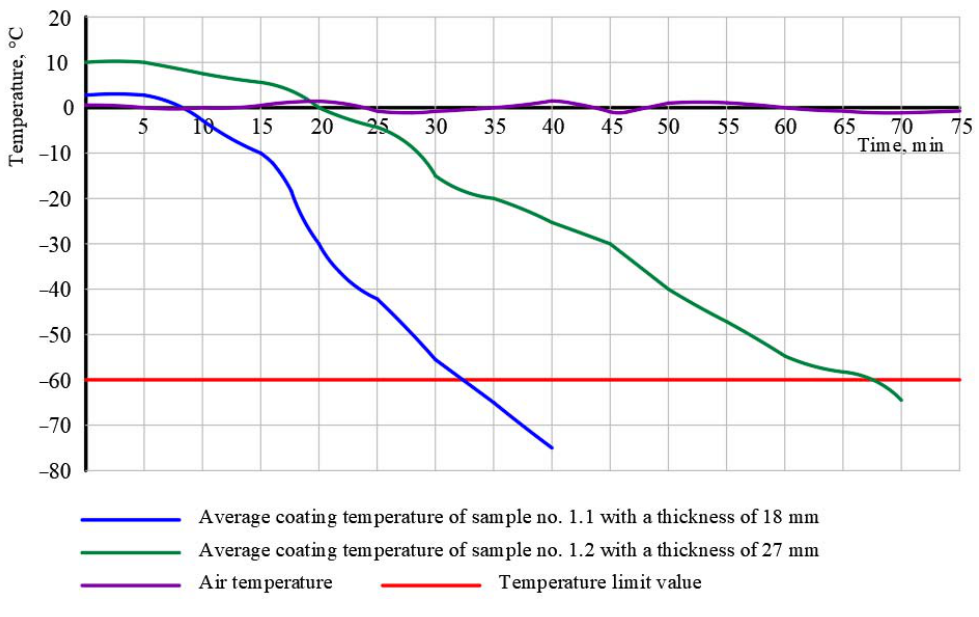
Figure 4. Cryogenic test temperature curves for sample no. 1.1 and sample no. 1.2.